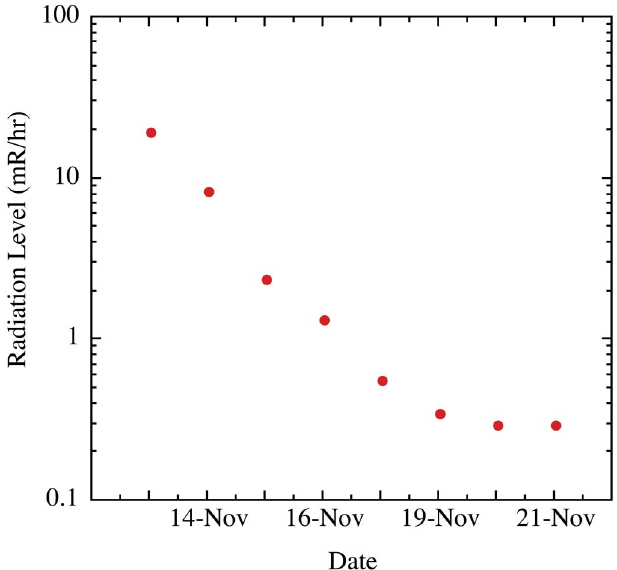
FIG. 3. (Color) Radiation level near the cavity as a function of time for B (cid:2) 0